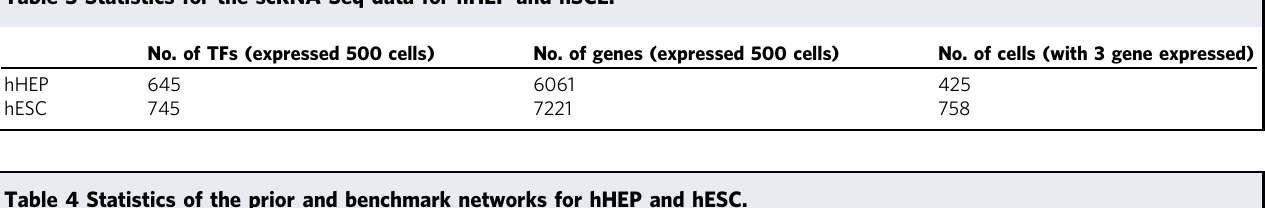
Table 4 Statistics of the prior and benchmark networks for hHEP and hESC. No. of TFs No. of genes No. of edges No. of overlap with